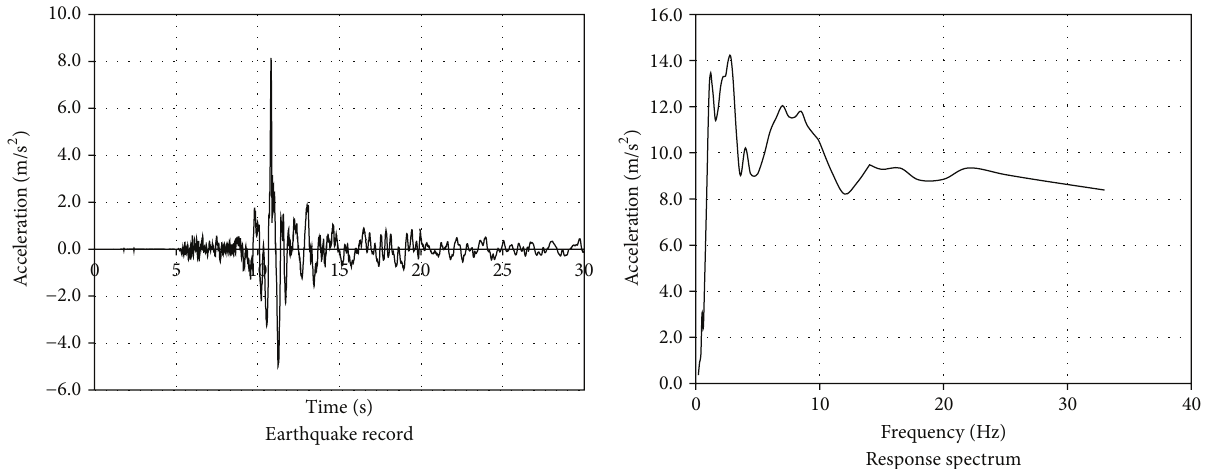
Figure 8: Record and response spectrum of Duzce, Turkey earthquake (November 12, 2012).